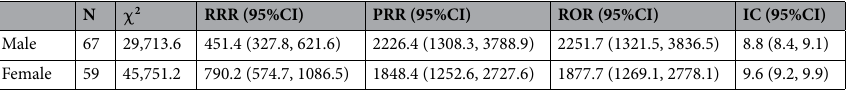
Table 3. The association between periostitis and voriconazole by sex. RRR relative reporting ratio, CI confidence interval, PRR proportional reporting ratio, ROR reporting odds ratio, IC information components.